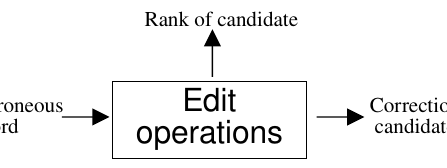
Figure 5. A priori spelling